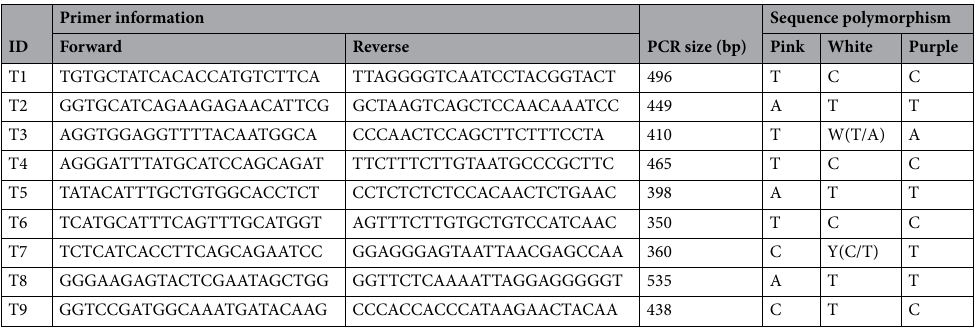
Table 3. Validation of candidate SNPs by genomic DNA PCR amplification and